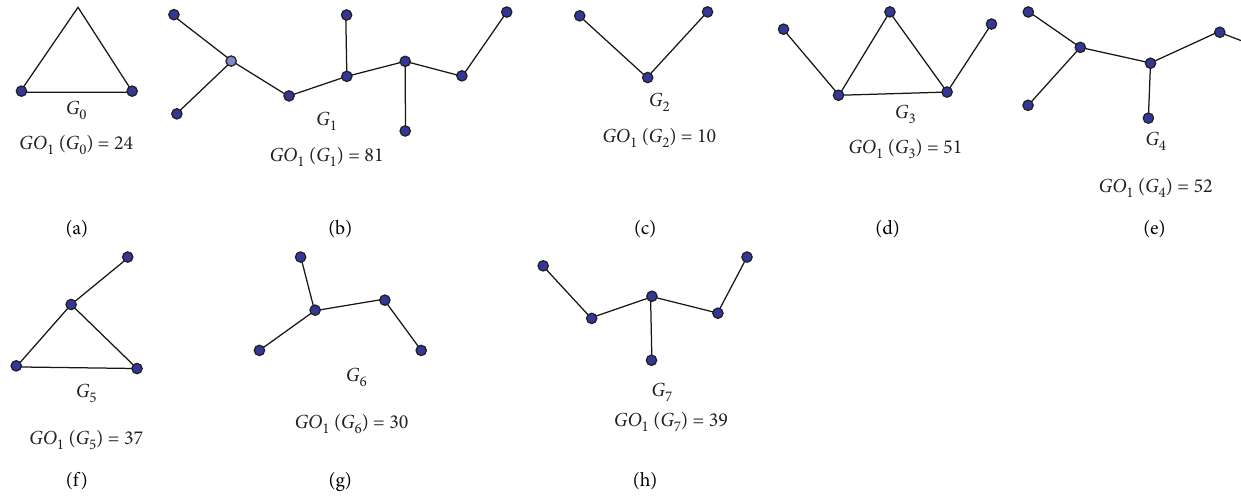
Figure 4: The graphs G